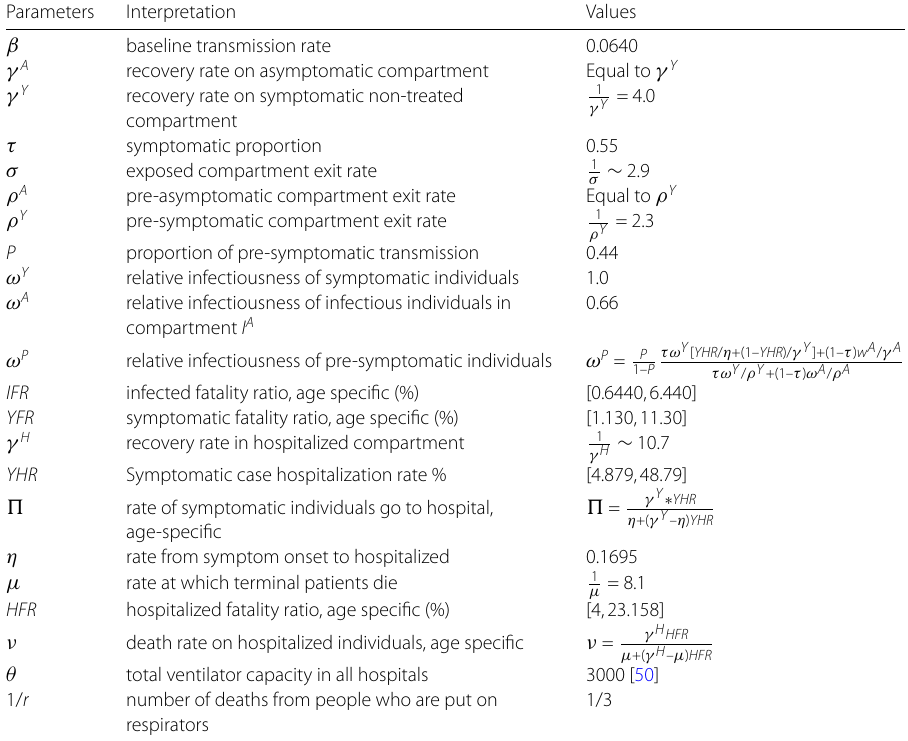
Table 1 Baseline parameters used in the model (based on [49])